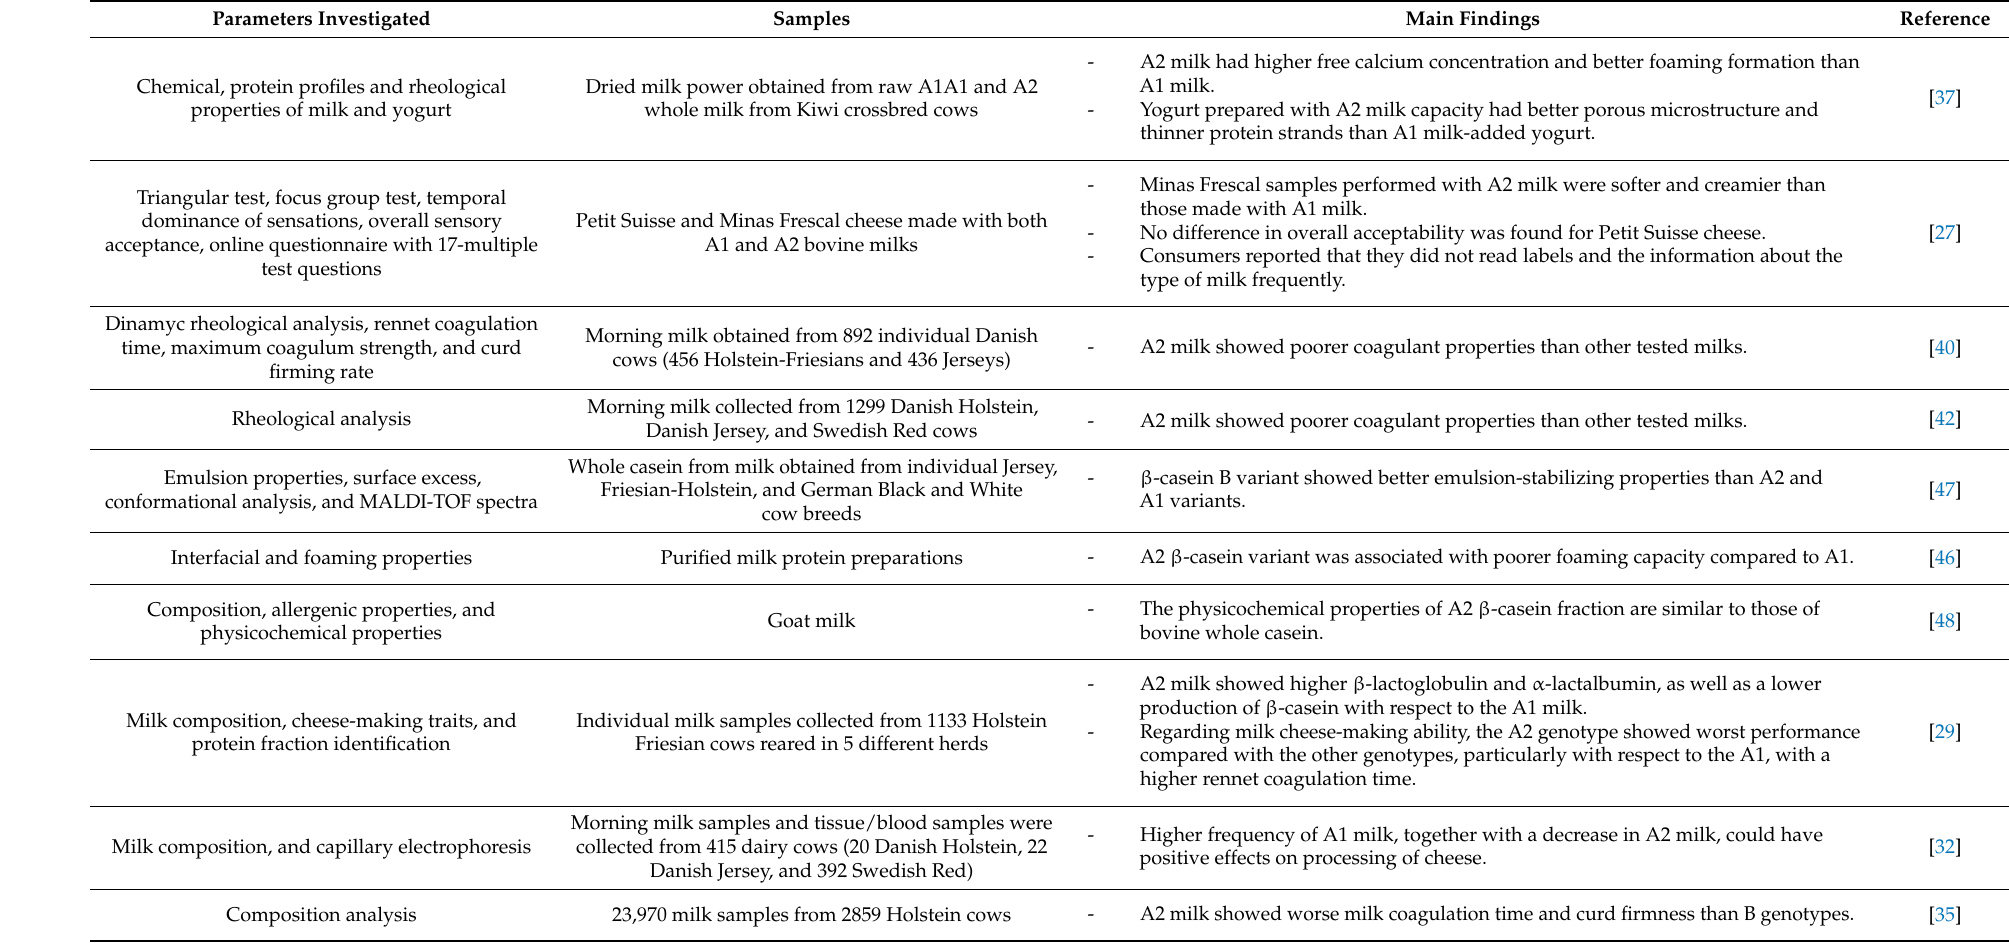
Table 1. Differences in sensory characteristics and technological properties of A1 and A2 milk and dairy